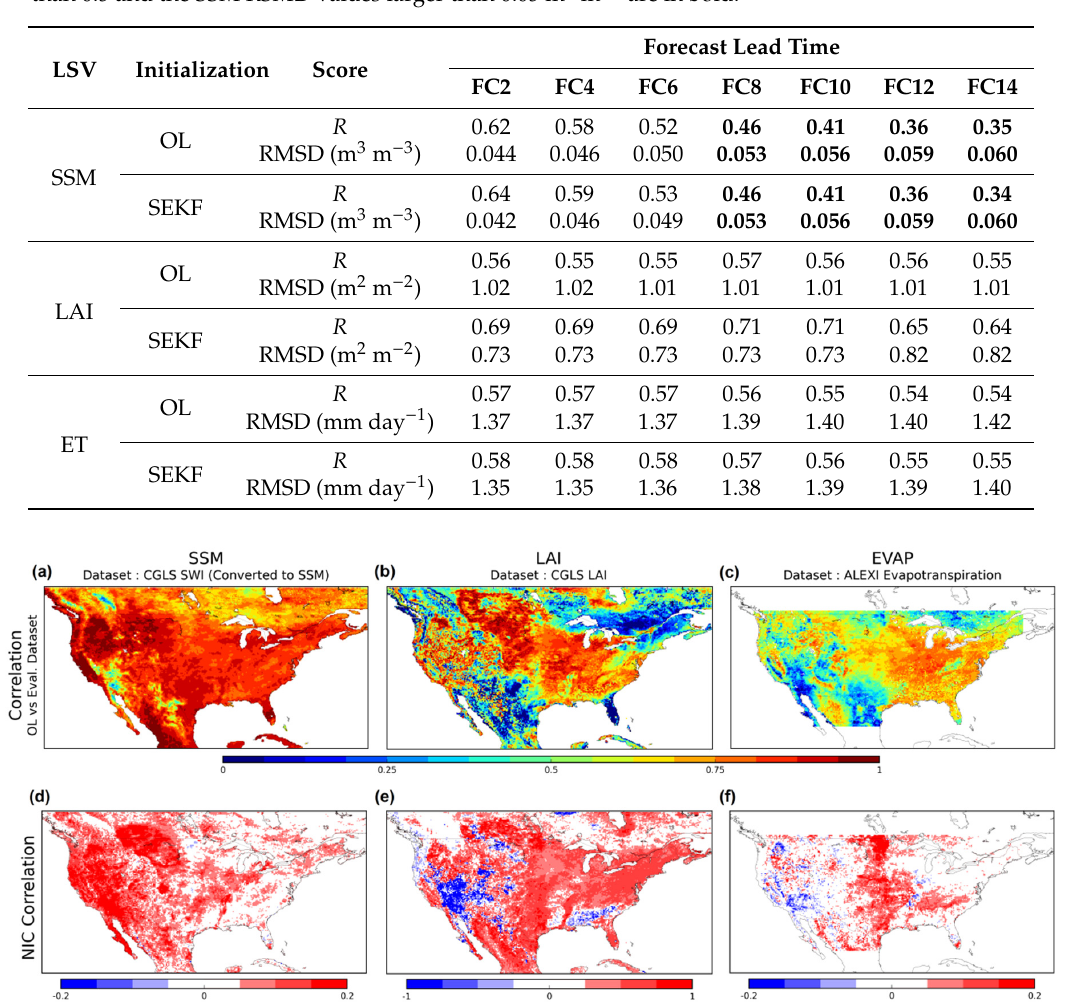
Table 2. Impact of forecast lead time and initialization on the prediction of surface soil moisture (SSM), LAI, and ET by LDAS-Monde over the CONUS, during the 2017–2018 time period. Only even values of forecast lead times are indicated, from 2 to 14 days (FC2 and FC14, respectively). The R values smaller